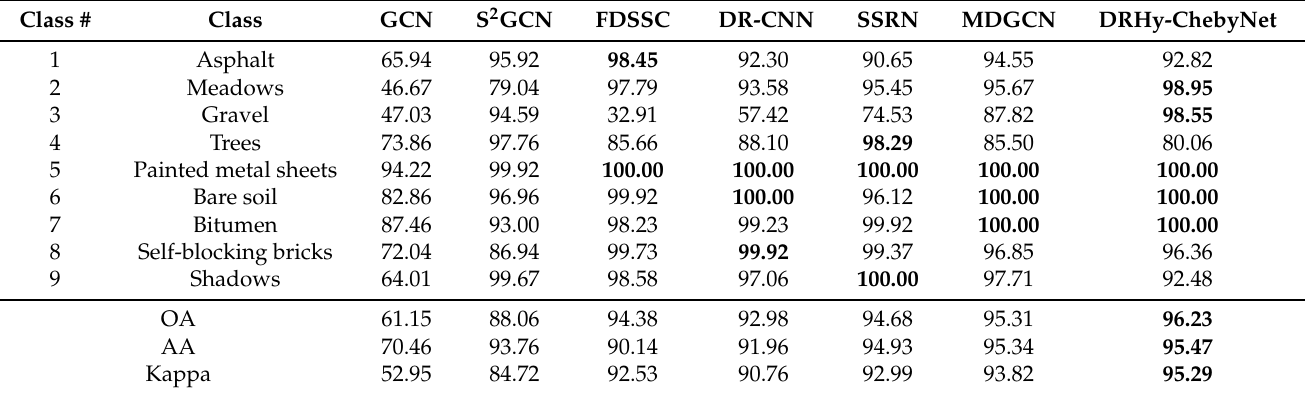
Table 4. Classification results of different methods on the University of Pavia